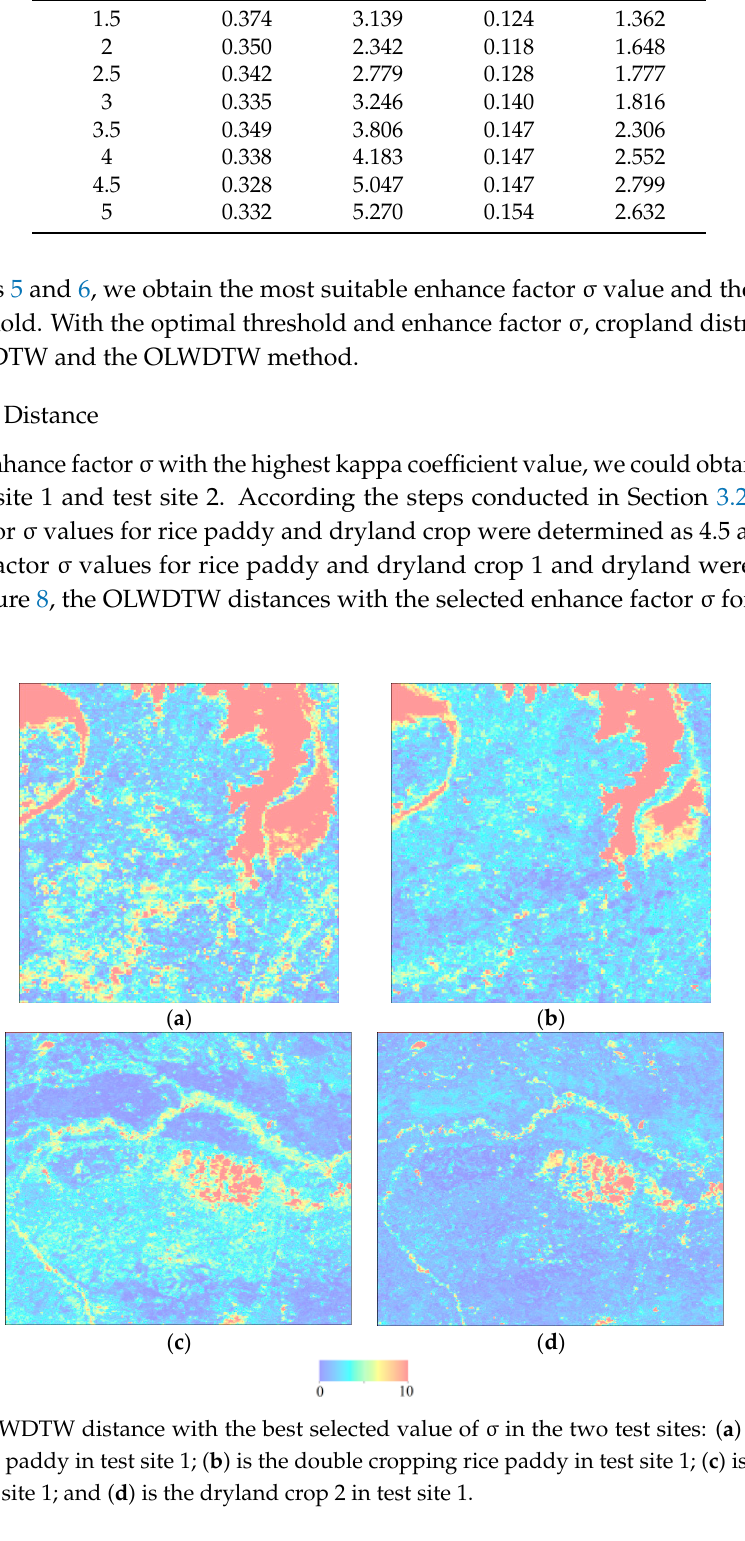
Table 6. Maximum kappa coefficient and the corresponding OLWDTW distance under different enhance factor σ values in test site 2.